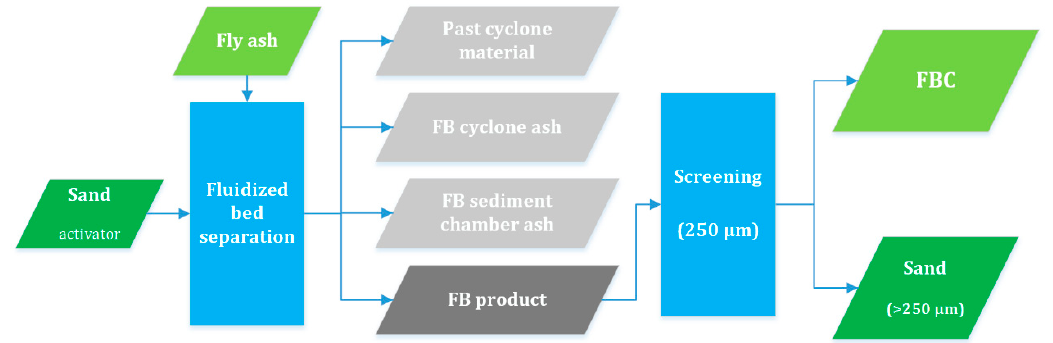
Figure 1. Fluidised bed (FB) separation scheme.